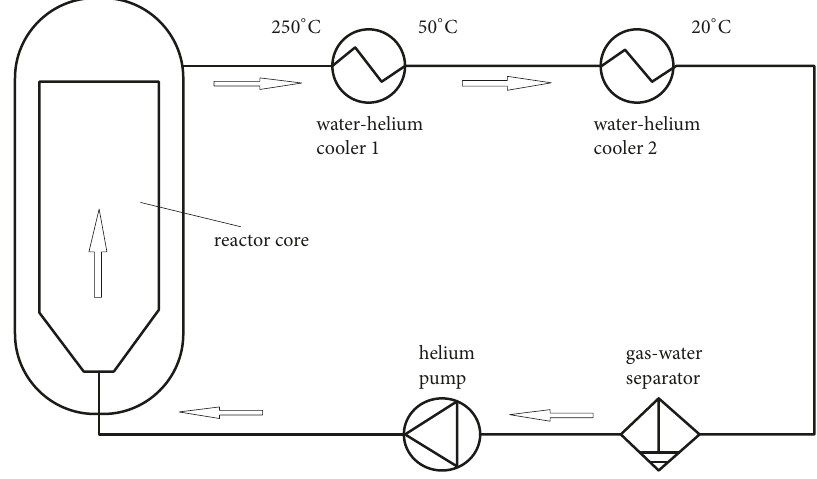
Figure 1: The dehumidification and purification system of